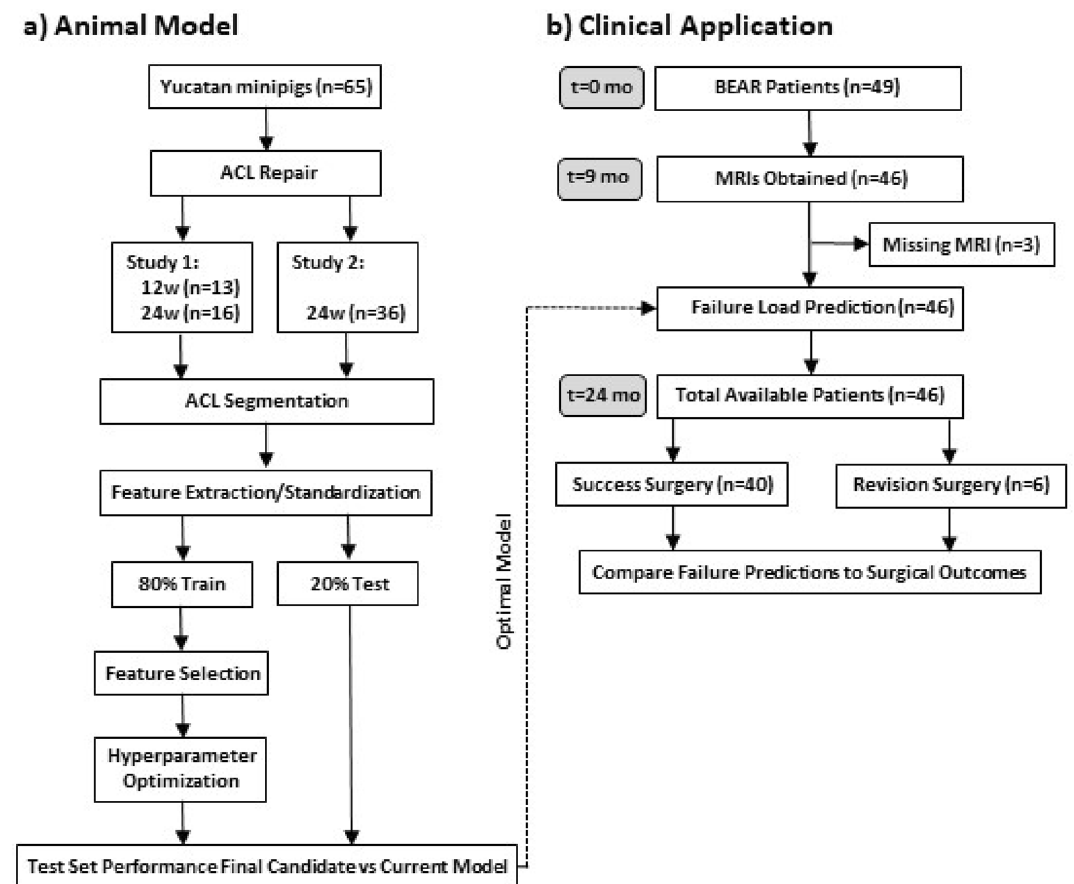
Figure 4. ( a ) Animal study to evaluate the five prediction models to select the one with the lowest mean absolute error (MAE). ( b ) STROBE diagram detailing the available BEAR III trial data analysis using the best prediction model determined in the animal study (dashed arrow). ACL anterior cruciate ligament, BEAR Bridge-enhanced ACL Restoration, t time, mo